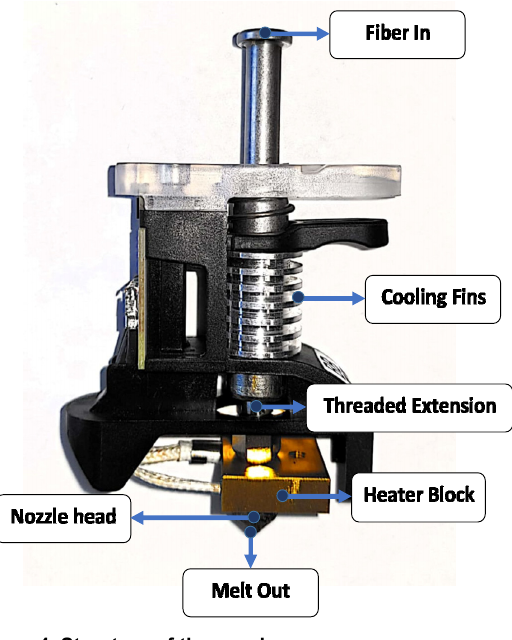
Figure 4. Structure of the nozzle This 3D printing does not detect when the nozzle is clogged. Other machines detect this phoneme. But in both cases, this maintenance problem requires periodic cleaning and too frequent loading of the nozzle. Cleaning operation must be performed when the 3D printer is stopped. So it is, from a Lean point of view, an internal operation as shown in Fig. 5.